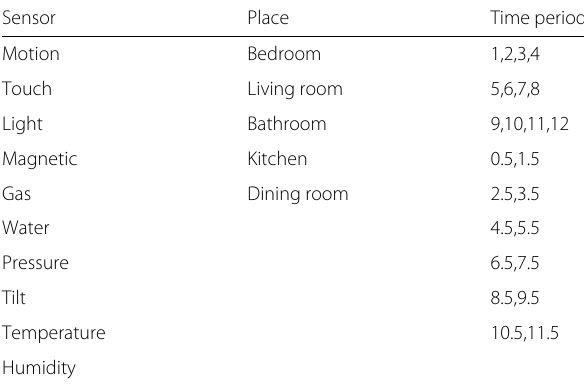
Table 1 Definition of the sensors, place, and time period Sensor Place Time period Motion Bedroom 1,2,3,4 Touch Living room 5,6,7,8 Light